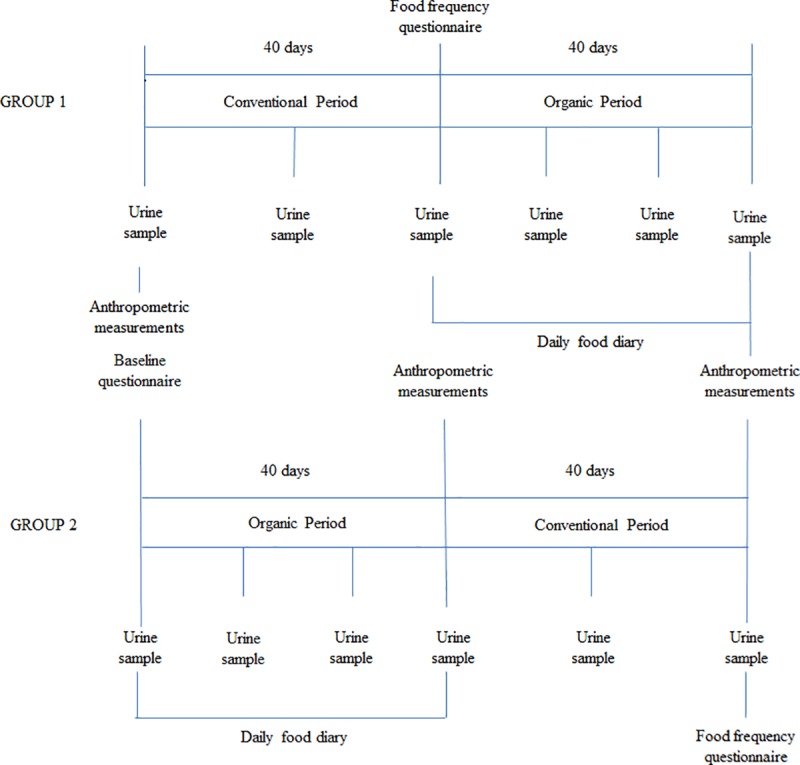
Study timeline and data collection procedure for the two groups of the study.